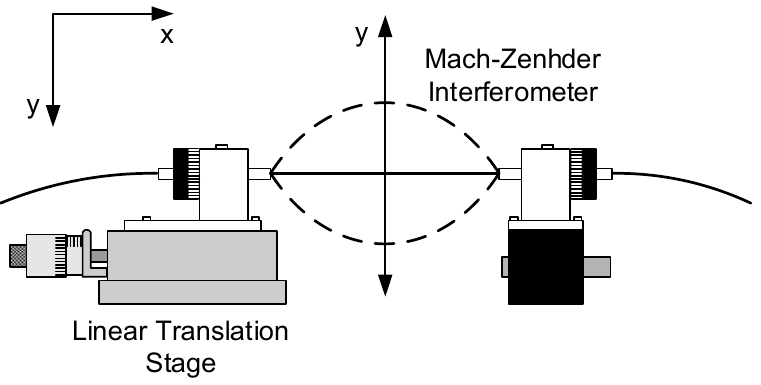
Figure 19. Detail of the mechanical system used to apply curvature and twist to the fiber interferometer.